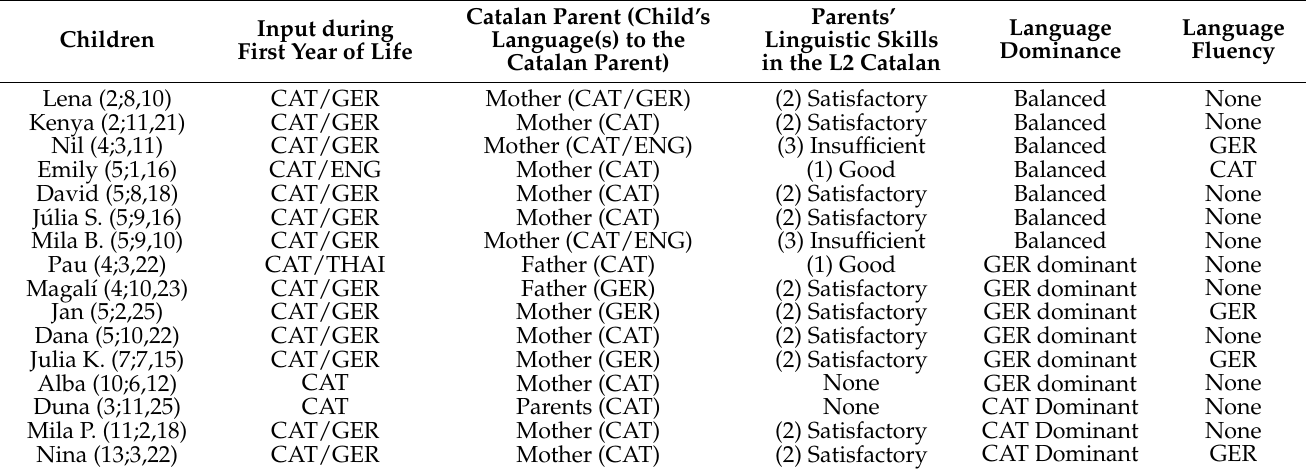
Table 13. Child-external factors ordered according to children’s language